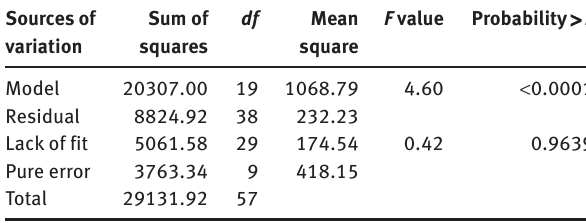
Table 3: ANOVA for quadratic model for Cd removal. Sources